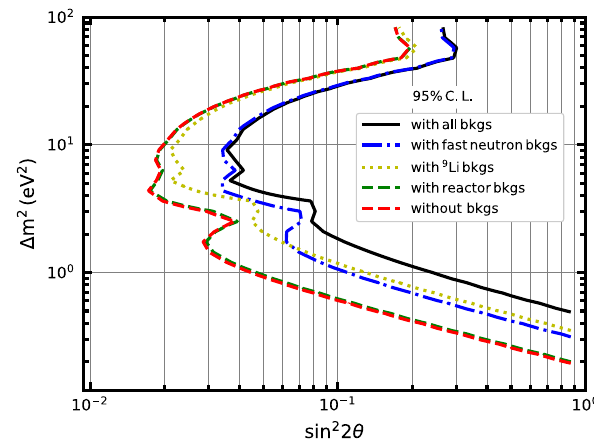
Fig. 6 The 95% C.L. sensitivity curves of the sterile neutrino search with different backgrounds included. The overburden is fixed to 20 m. The black solid curve corresponds to the analysis with all three back- grounds considered. The blue dash-dotted curve considers only the fast neutron backgrounds, while the yellow dotted curve considers only 9 Li backgrounds and the green dashed curve only reactor backgrounds. The red dashed curve corresponds to the no background